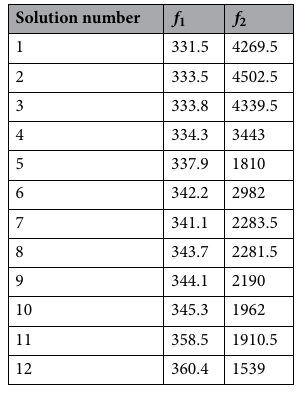
Table 8. Pareto answers from 5 patients and 4